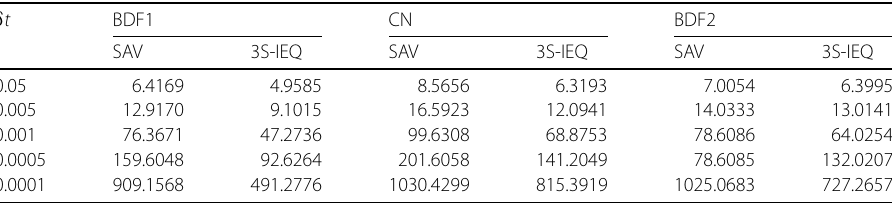
Table 3 The CPU times compared with SAV method in [11] δ